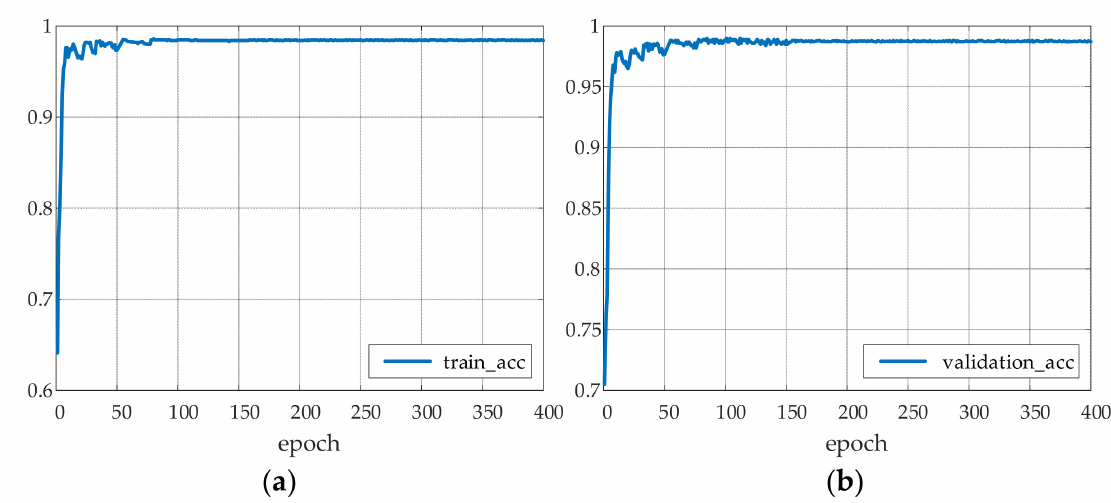
Figure 9. Accuracy test curves: ( a ) is the training accuracy of YOLOv4; ( b ) is the validation accuracy of